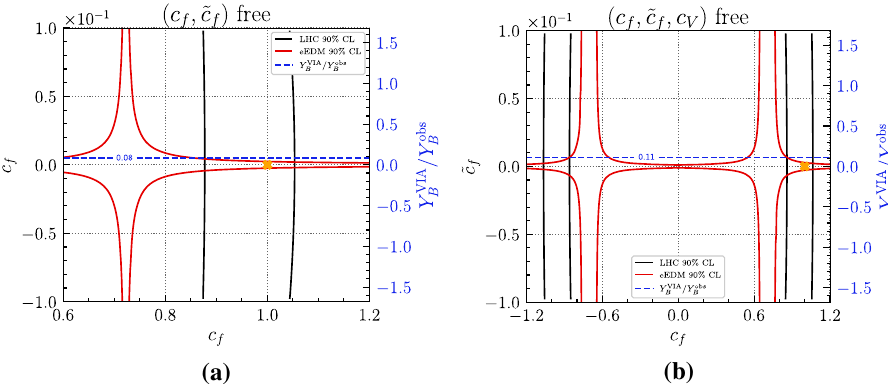
Fig. 13 Fermion, fermion+V models: constraints on the global Higgs–fermion coupling modifiers c f and ˜ c f where c V is a set to its SM value or b free-floating in the fit. The legend corresponds to the one in Fig. 9